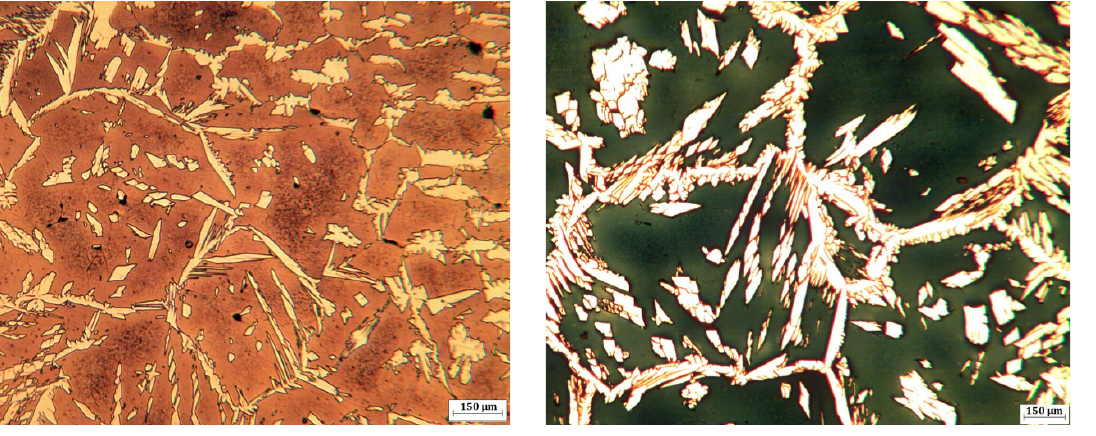
Figure 11. Microstructure from the 2205 DSS HTHAZ (0.6 kJ mm –1 ).